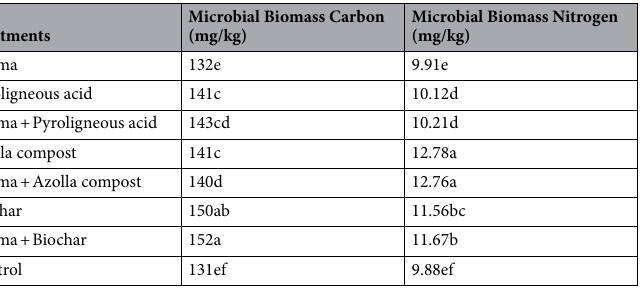
Table 7. Mean comparison of effect of application of plasma, pyroligneous acid, azolla compost and biochar on microbial changes of soil in the field average 2016–17. Means in each column followed by similar letter(s) are not significantly different at 5% probability level using LSD Range